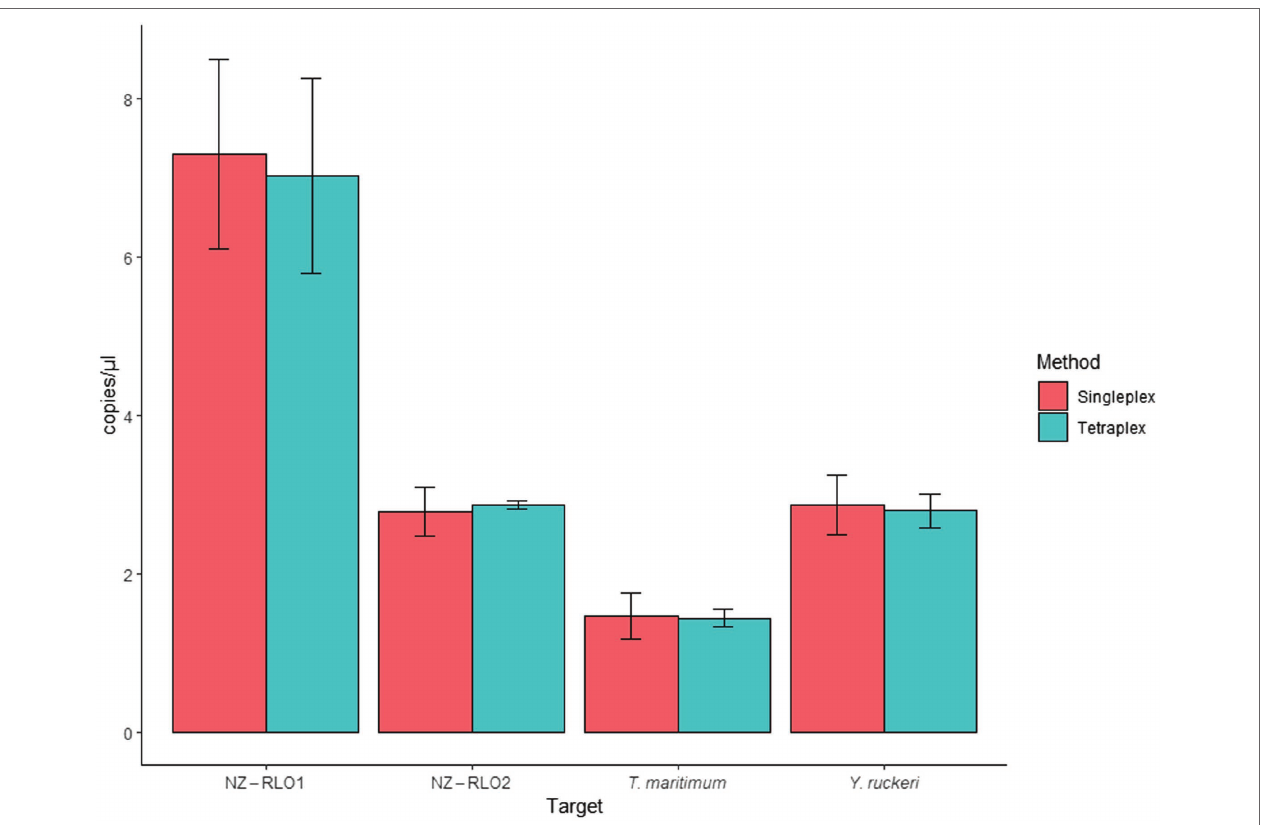
FIGURE 3 | Droplet digital PCR singleplex and tetraplex assays run for bacterial isolates for NZ-RLO1, NZ-RLO2, Tenacibaculum maritimum , and Yersinia ruckeri in copies/ μ l. Error bars describe the standard error (SE) of the triplicate